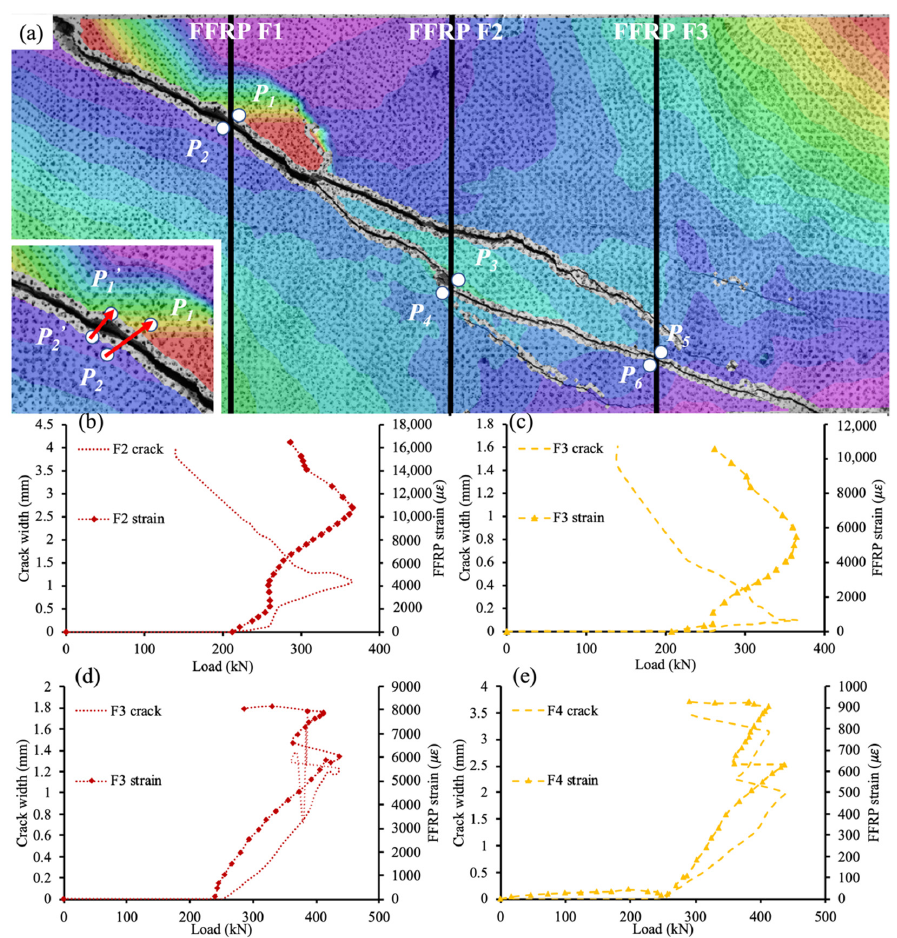
Figure 11. Crack-FFRP strain relation: ( a ) method; ( b ) F2 crack in specimen 10 × 30 @ 200; ( c ) F3 crack in specimen 10 × 30 @ 200; ( d ) F3 crack in specimen 10 × 60 @ 100; and ( e ) F4 crack in specimen 10 × 60 @ 100. Figure 11b–e illustrate the relation between crack width and FFRP strain for four in- tersections on two different specimens (two intersections each specimen): specimen 10 ×